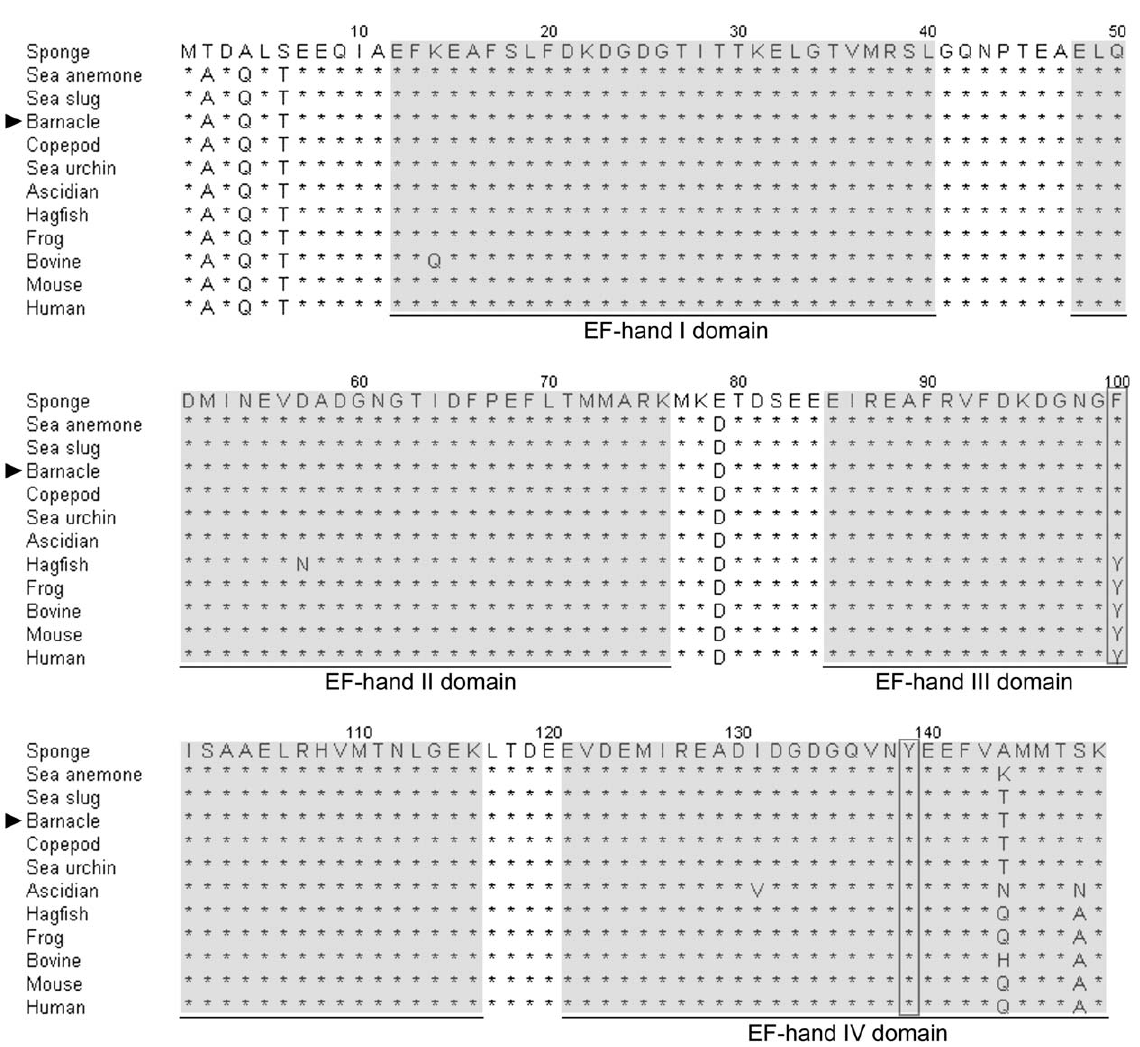
Figure 2. Multiple alignment of the amino acid sequence of CaM in B.amphitrite with its homologs in sponge (BAB61797.1), sea anemone (BAB61796.1), sea slug (NP_001191509.1), copepod (ACO10440.1), sea urchin (BAB89360.1), ascidian (NP_001027633.1), hagfish (AAD56955.1), frog (NP_001080864.1), bovine (NP_001159980.1), mouse (AAH54805.1), and human (AAD45181.1). Amino acids are numbered and asterisks (*) indicate the identical amino acids. The four EF-hand domains are underlined and the letters in boxes show the conserved tyrosine (Y) residues generally found in most invertebrates. The numbers above the sequences show the amino acid position. The shaded areas are EF-hand domains.